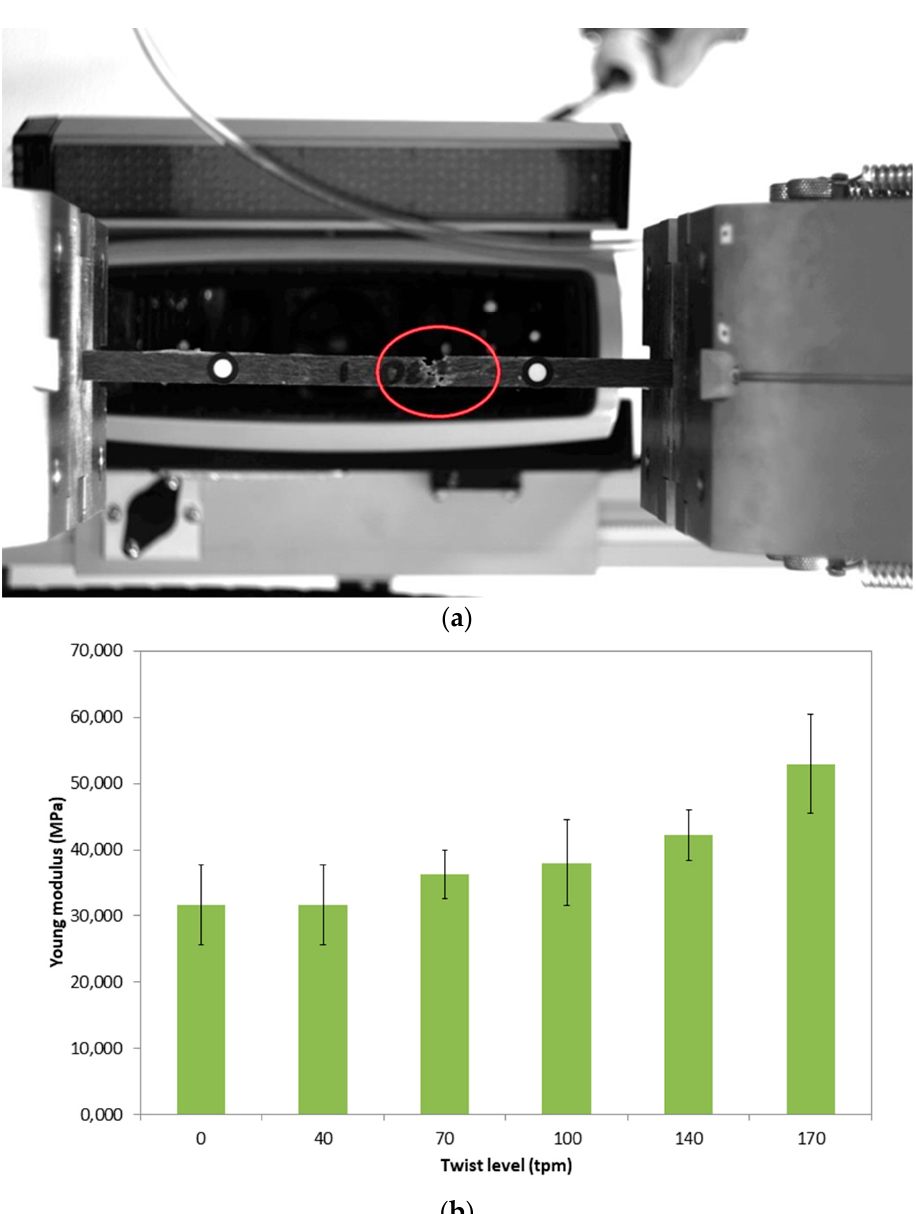
Figure 3. Impregnated fiber bundle test. ( a ) Sample at break; ( b ) fibers modulus Ef back-calculated from Equations (1) and (2).